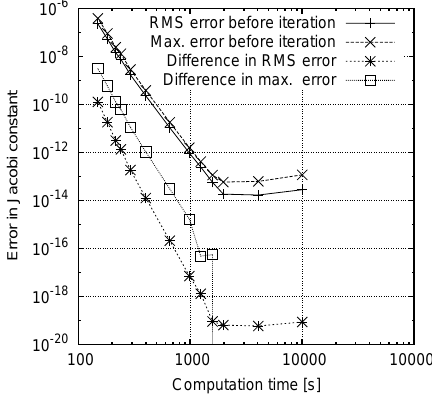
Fig. 14. The RMS and maximum errors in the Jacobi constant before secant method iteration to the surface, and the resulting difference in the errors after the